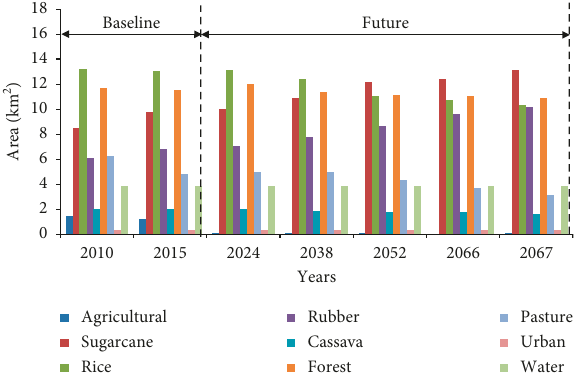
Figure 8: Historical and simulated land use areas above the Huay Ling Jone